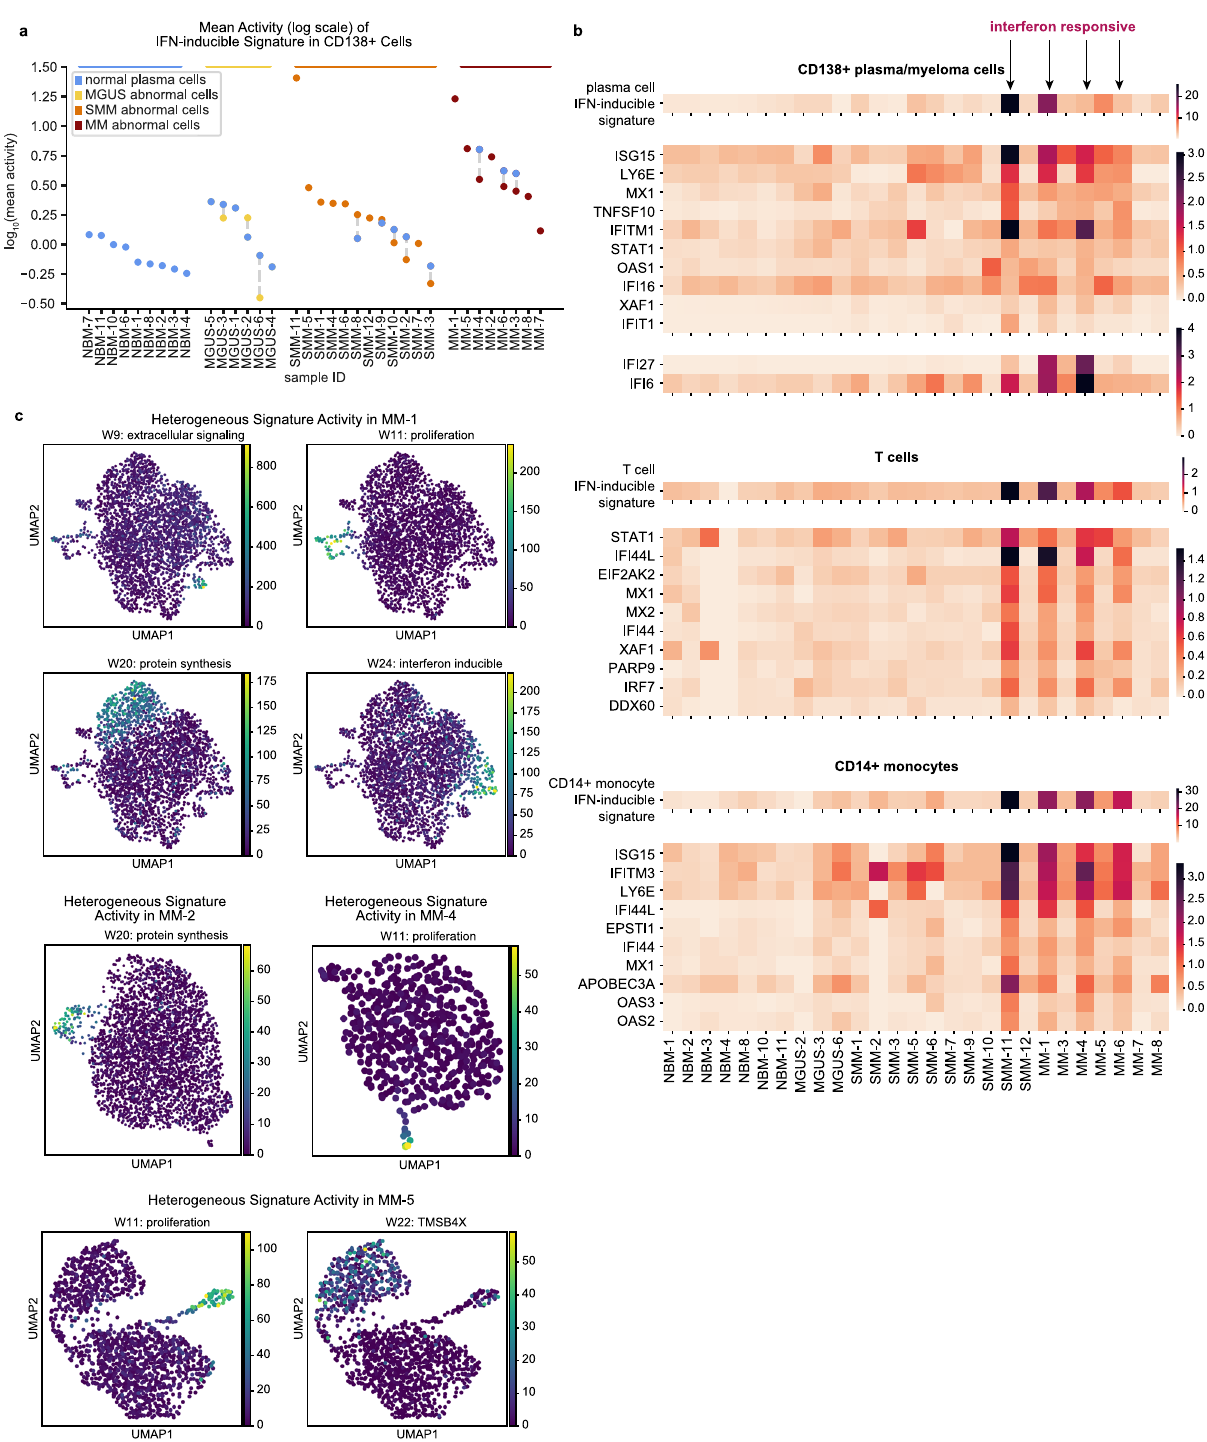
Fig. 4 | IFN-inducible signature is correlated between CD138+ and micro- environment cells, and gene signatures exhibit intratumor heterogeneity. a Mean activity ± s.e.m. of CD138+ IFN-inducible signature across normal and abnormal plasma cell populations. Both normal and abnormal plasma cells exhibit signi fi cantly increased activity of the interferon-inducible signature in MM vs. NBM ( q =5.2×10 − 3 and q =3.2×10 − 4 , resp.). Source data are provided as a Source Data File. b Mean activity per sample of IFN-inducible signature discovered in CD138+ cells (top), T cells (middle) and CD14+ monocytes (bottom). Mean expressionlevels for thetengeneswiththe highestvaluesinthe Wmatrixforeach